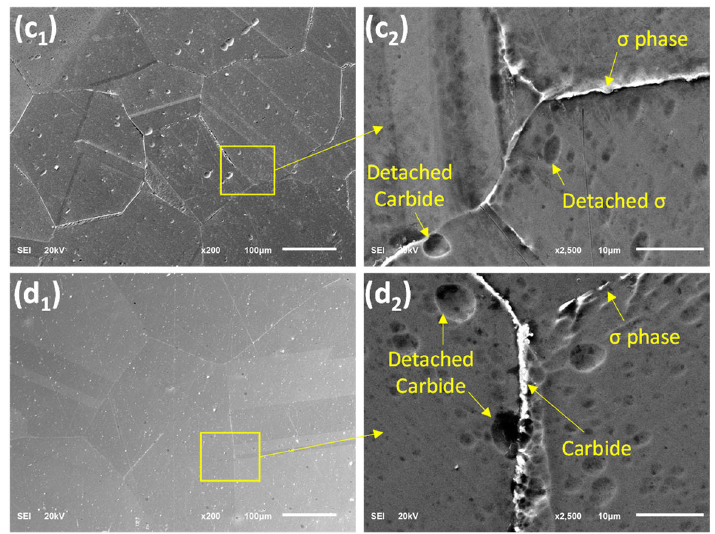
Figure 6. SEM images showing the grains and the grain boundaries for heat ‐ treated samples ( a 1 , a 2 ) AT10, ( b 1 ,b 2 ) AT11, ( c 1 , c 2 ) AT12, and ( d 1 , d 2 )